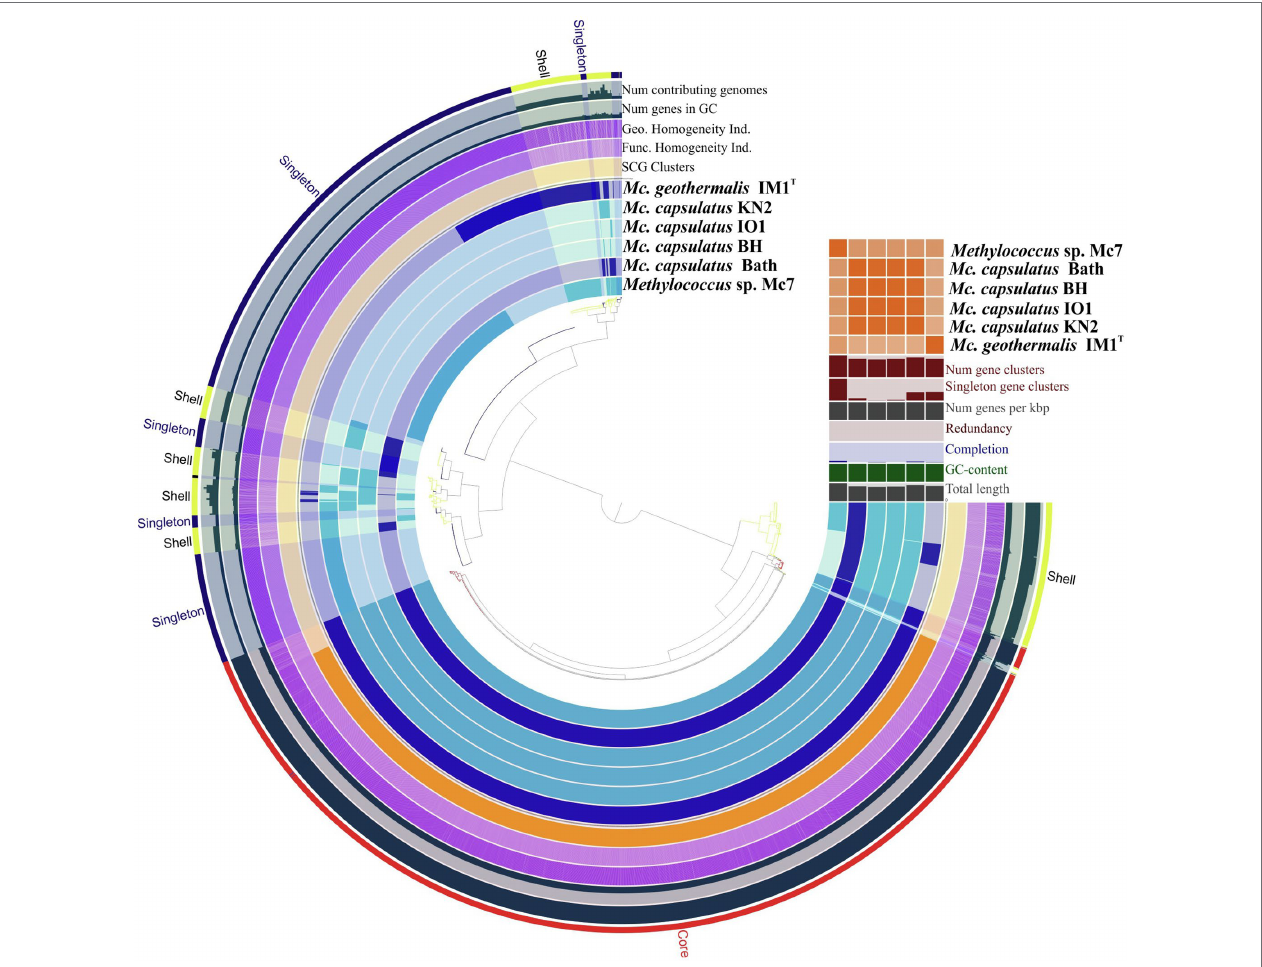
FIGURE 6 | Pan-genome analysis. Clustering of genomes based on the presence/absence patterns of 4,485 pan-genomic clusters. The genomes are organized in radial layers as core, singleton, and shell gene clusters (Euclidean distance; Ward linkage) which are defined by the gene tree in the center. Genomes of new isolates are colored by blue. Genomes of Methylococcus capsulatus Bath and Methylococcus geothermalis IM1 T are colored by dark blue. Line segments indicate single gene clusters. The outermost circles carry the information regarding the number of genomes containing specific gene cluster, number of genes in gene clusters (gray), functional, geometric, and combined homogeneity indexes (purple), distribution of single-copy gene clusters (orange circle). The layers below the heatmap display from the bottom to top: total length of the genomes, GC content, genomes completion, redundancy of each genome, number of genes per kbp, number of singleton gene clusters, total number of gene clusters. Heatmap denotes correlation between the genomes based on average nucleotide identity values calculated using